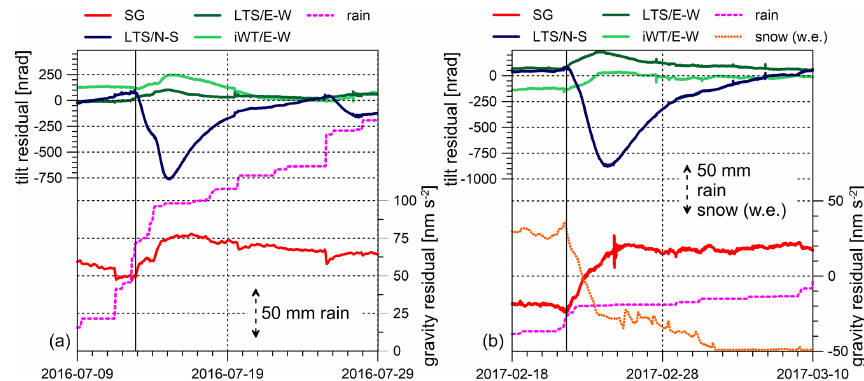
Figure 9. Long-term gravity and tilt residual signals caused by hydrological processes after heavy and long-lasting rain (a) and during rapid snowmelt (b) . N–S tilt residuals (dark blue) and E–W tilt residuals (LTS/dark green and iWT/light green). SG gravity residuals (red). Cumulative rain (dashed magenta line), snow (water equivalent; dotted orange line). Scales for rain and snow water equivalent indicated by arrows. The black vertical line shows the onset of the long-term residual anomaly.